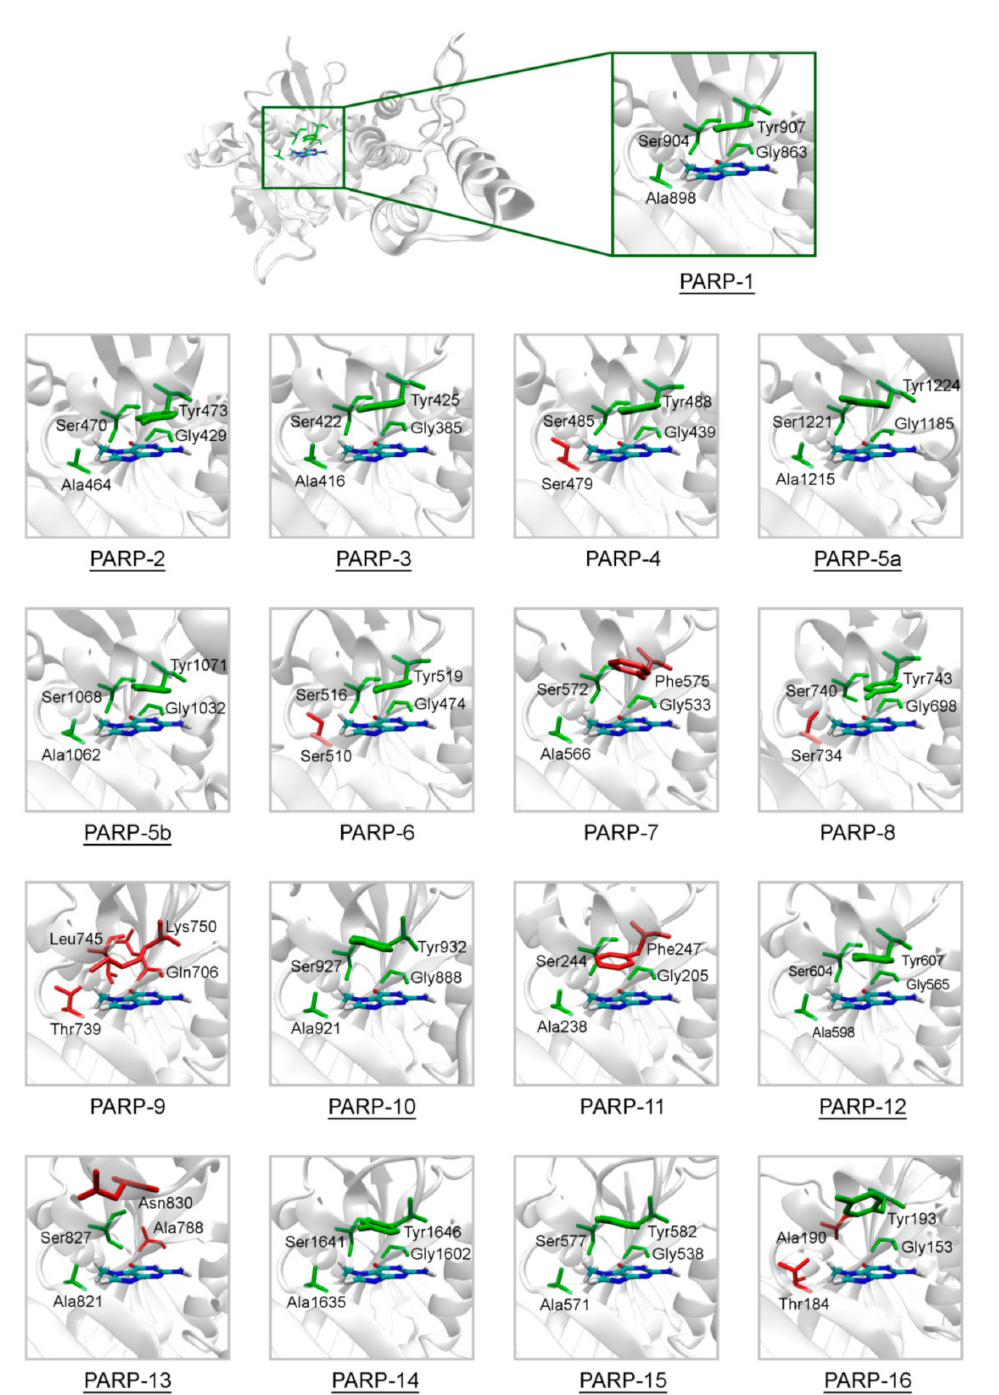
Figure 2. Structure of the NA binding site in PARPs 1–16. Underlined PARP structures (1–3, 5a, 5b, 10, 12–16) were obtained from the Protein Data Bank, and other structures (4, 6–9, 11) were obtained by homology modeling. Amino acid substitutions in the NA site are marked in red. The NA site architecture is quite similar in PARPs 1–3, 5a, 5b, 10, 12, 14, and 15 due to the lack of substitutions. The coordinates of the 7-MG molecule (colored by atom type) are transferred from the docking model of PARP-1–7-MG